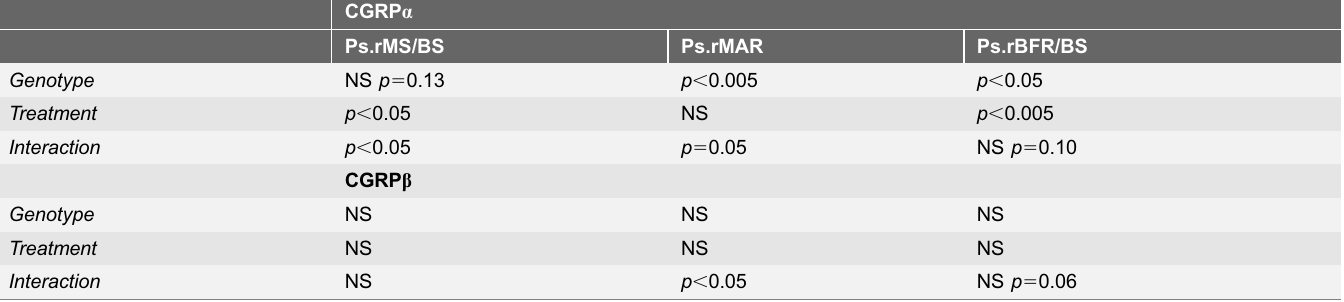
Table 3. Summary of two-way ANOVA results for load-induced periosteal relative bone formation in CGRP a and CGRP b wildtype and knockout